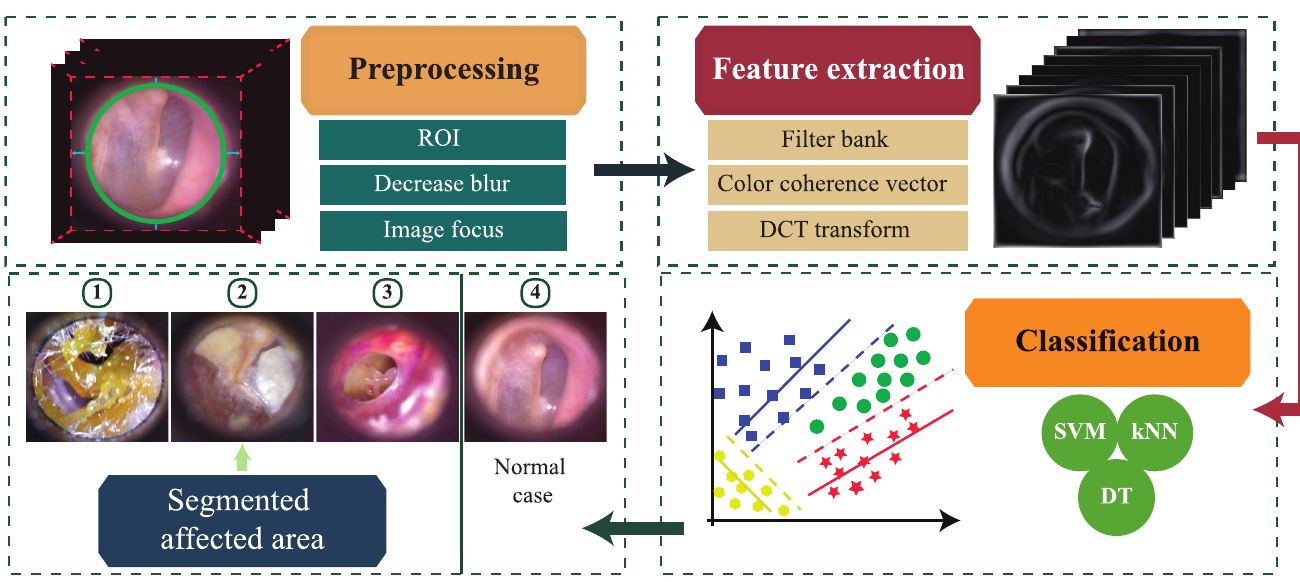
Fig 1. General scheme of the computer-aided system approach to assist the diagnosis of external and middle ear conditions. We selected the feature extraction method and classifier that produce the highest validation accuracy to use in our proposed system. The area under medical suspicion is highlighted for visualization purposes for general practitioner.